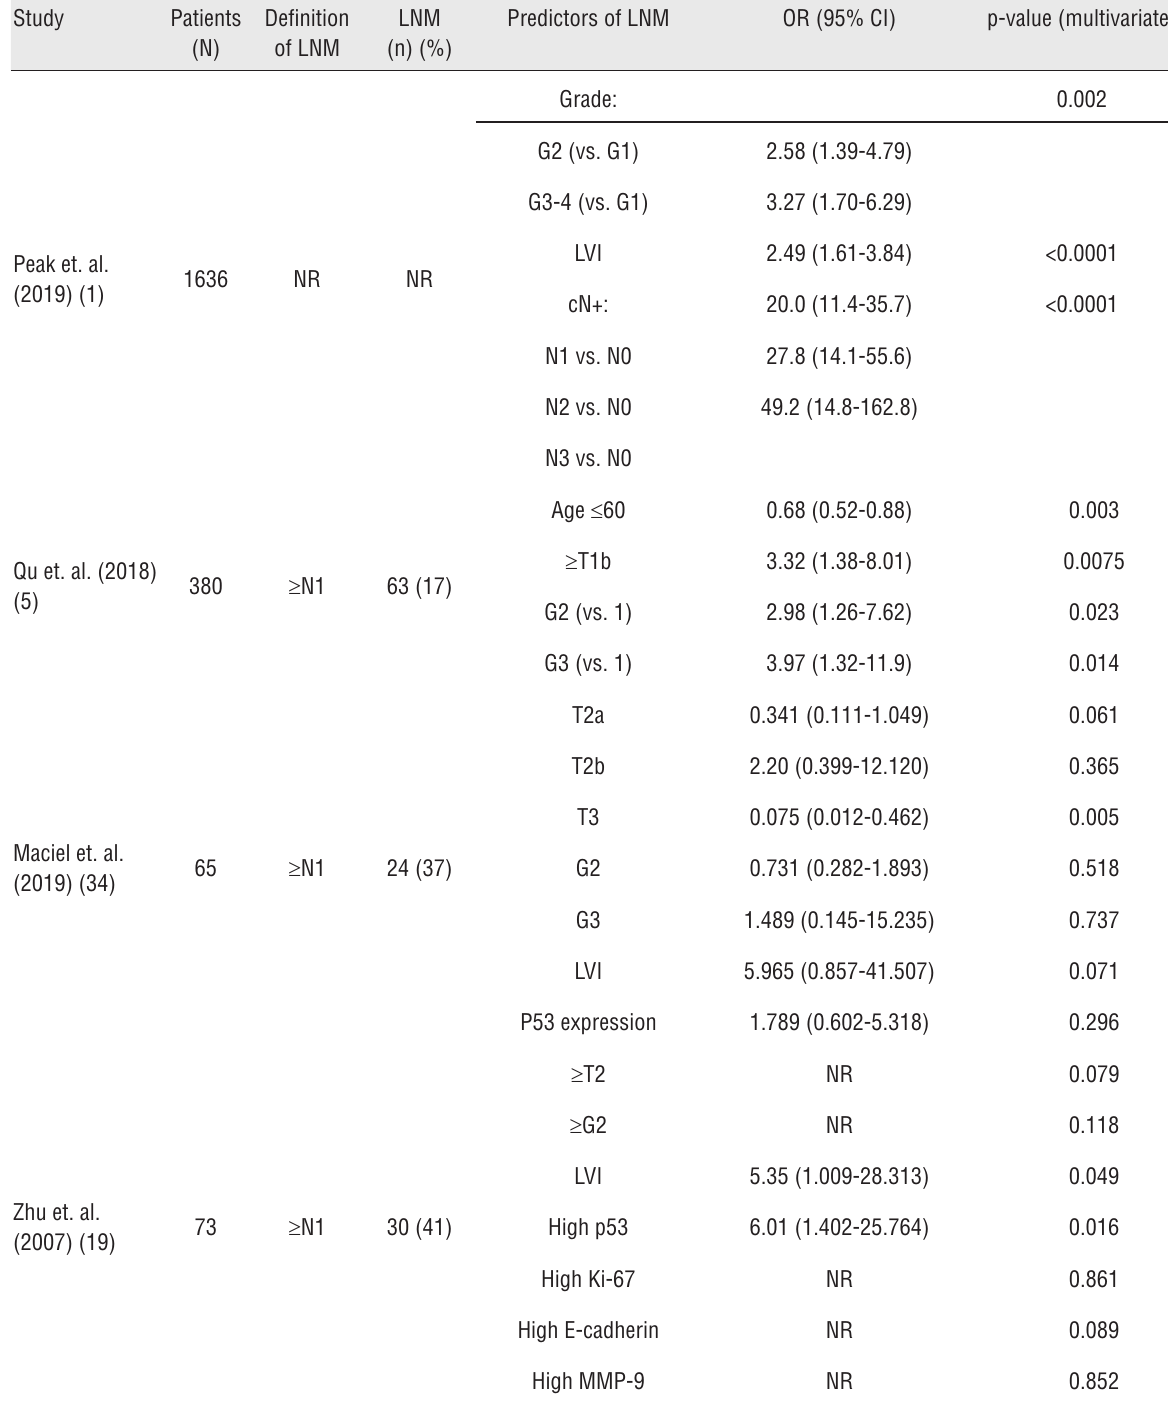
Table 1 - Original studies reviewed with factors examined for lymph node metastasis and corresponding statistical significance on multivariate